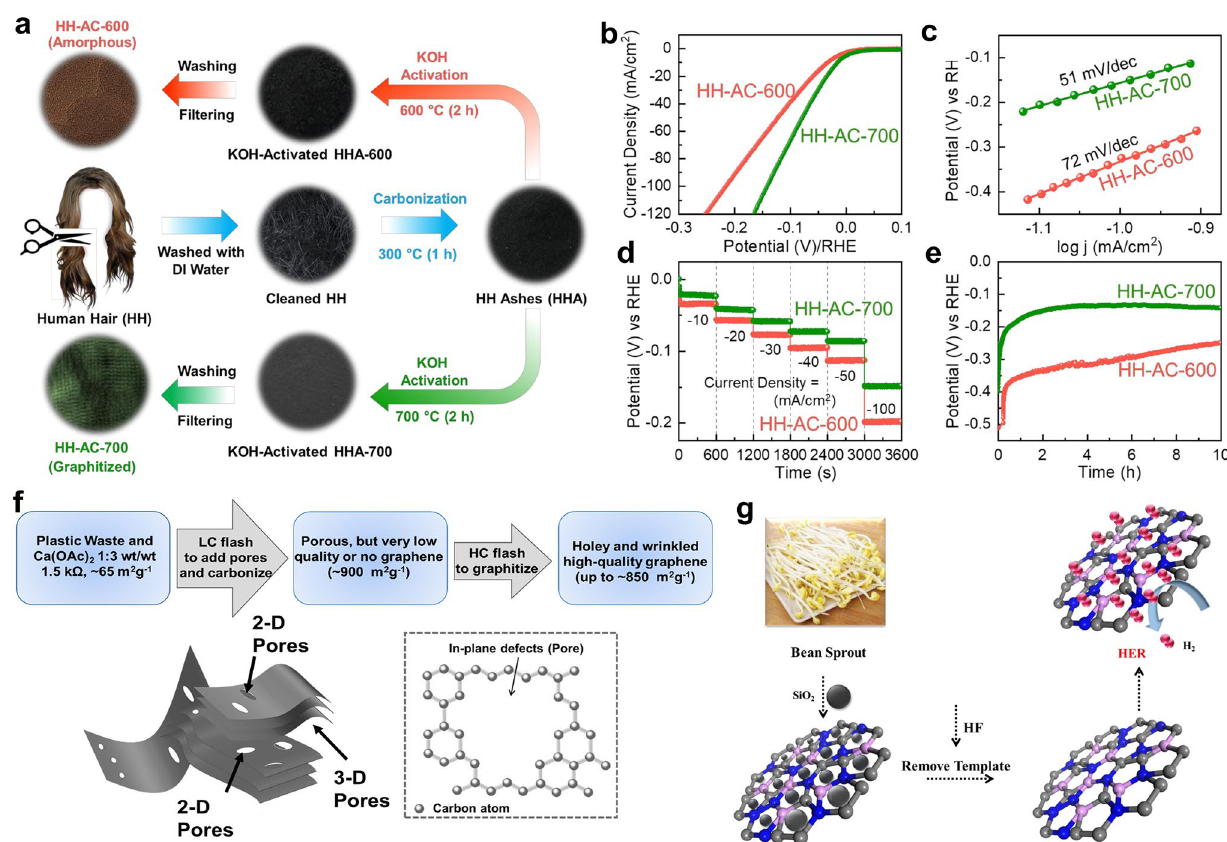
Fig. 5 a Scheme of the preparation of human hair‑derived HH‑AC‑700 layered nanobundles and HH‑AC‑600 nanobundles. b LSV curves, c Tafel plots, d multi‑chronopotentiometry profiles, and e time‑dependent HER stability for HH‑AC‑700 and HH‑AC‑600 catalysts [67]. Copy‑ right 2022, MDPI. f Illustration of the HWFG preparation process, and the diagram of HWFG’s porous structure [103]. Copyright 2022, Ameri‑ can Chemical Society. g Scheme of the fabrication process of bean sprouts carbon materials [38]. Copyright 2021,